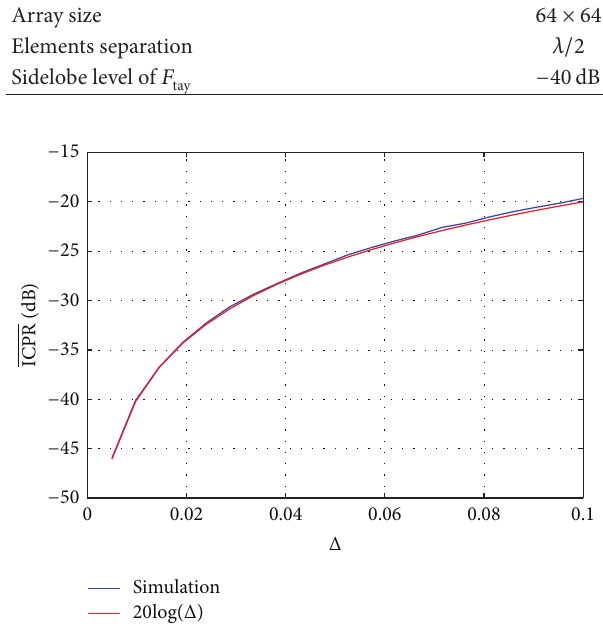
Figure 5: The relation between Δ and ICPR.